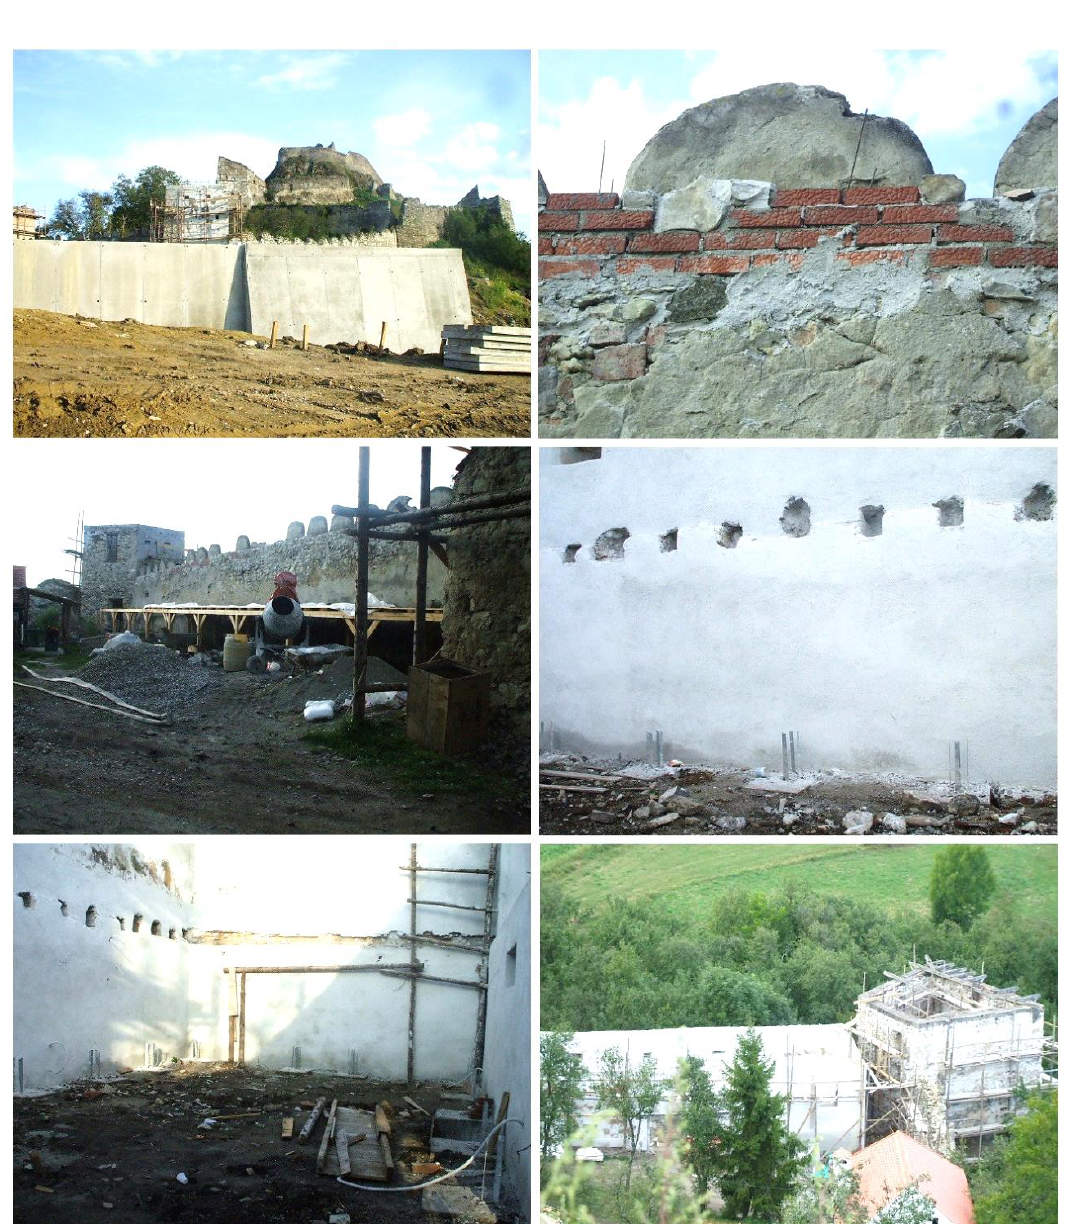
Figure 6: Details captured during rehabilitation (September 2010), underlining the invasive methods based on the extensive use of concrete in historical walls and foundations Photos by Monica POPOVICI (September